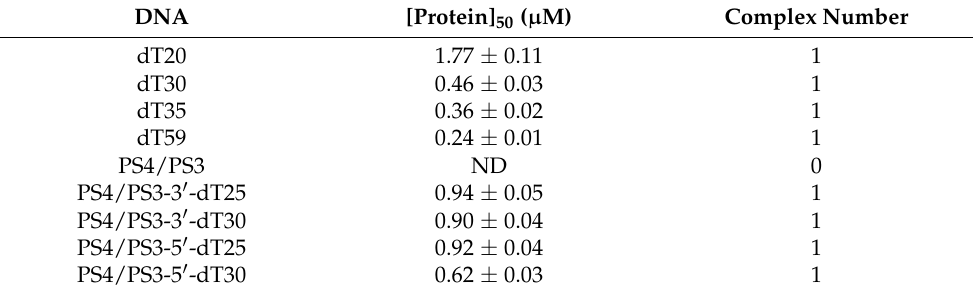
Table 1. ssDNA binding properties of SaSsbA as analyzed via EMSA. DNA